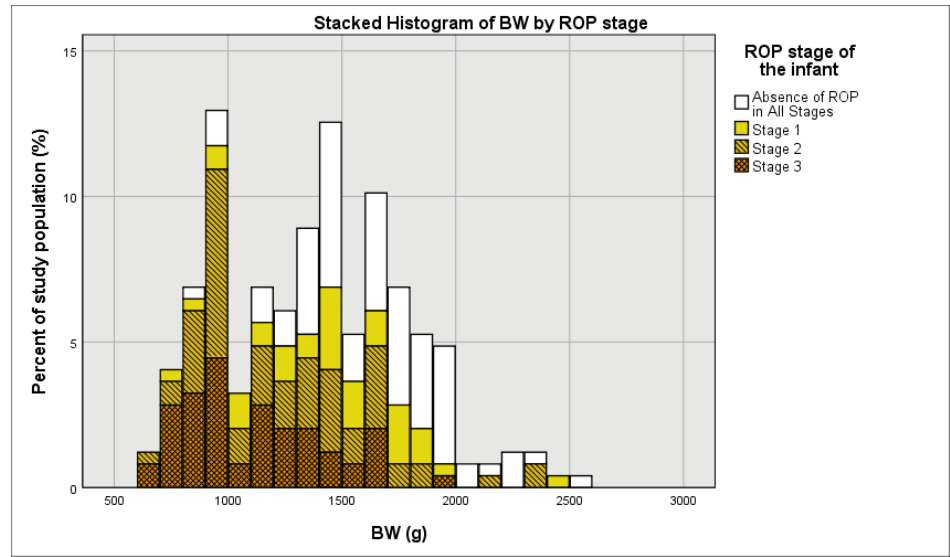
Figure 2. Distribution of BW (in 100 g increments) stratified by ROP stage.